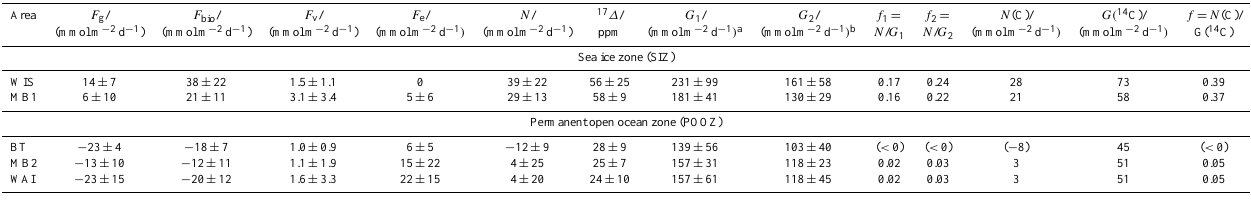
Table 2. Mixed-layer net and gross oxygen production and related variables. Positive F g , F v , F e and F bio values mean a net loss of oxygen from the mixed layer. Net community production is calculated as N = F bio + F v + F e .